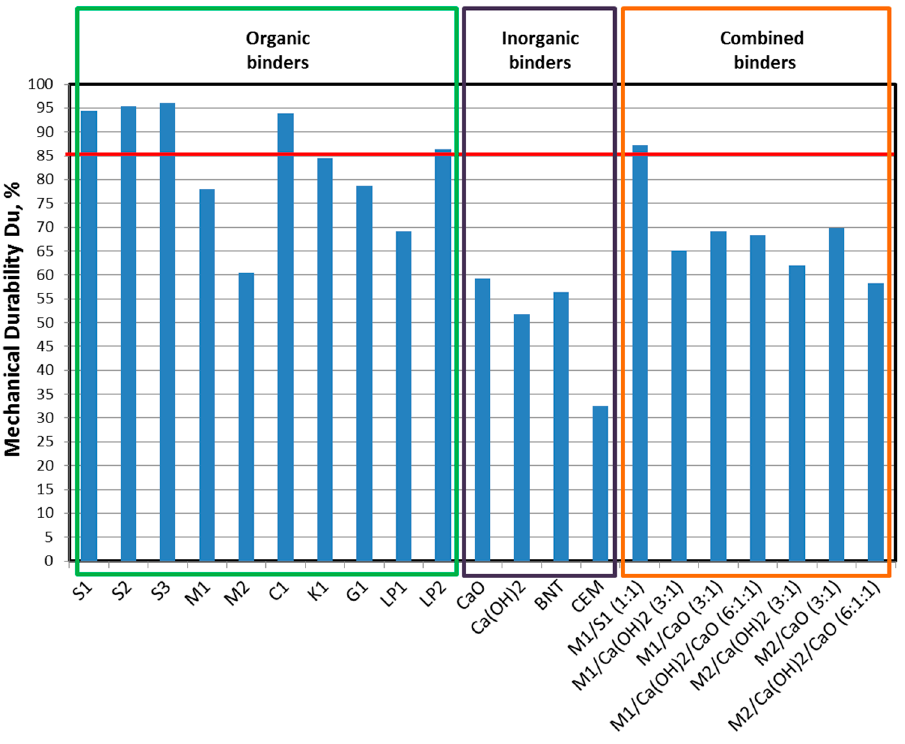
Figure 4. Influence of binder type on mechanical durability of briquettes.